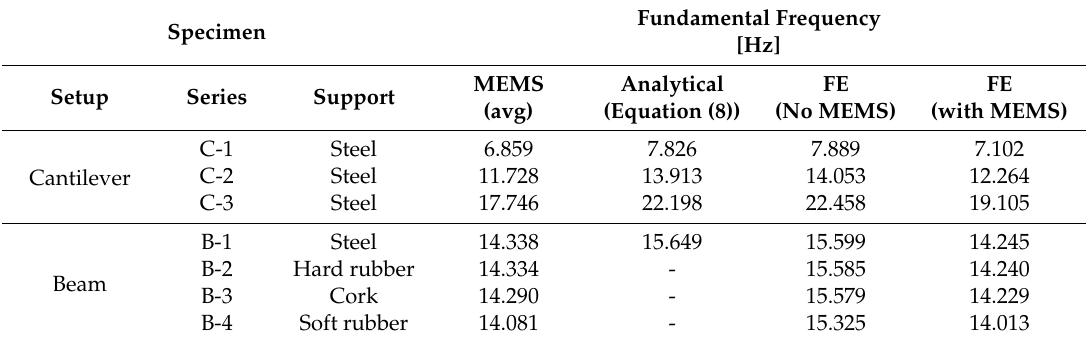
Table 2. Experimental (average of MEMS measurements), analytical and numerical prediction of fundamental